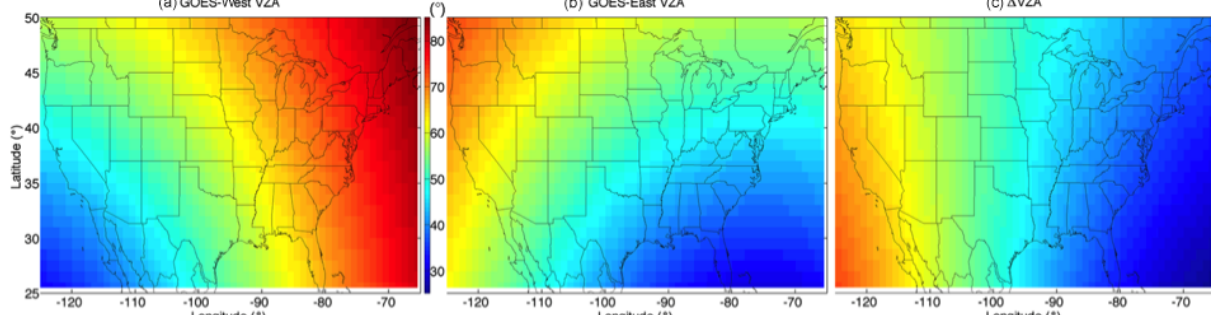
Figure 7. Viewing zenith angles for (a) GOES-West and (b) GOES-East, and (c) their differences over the matching